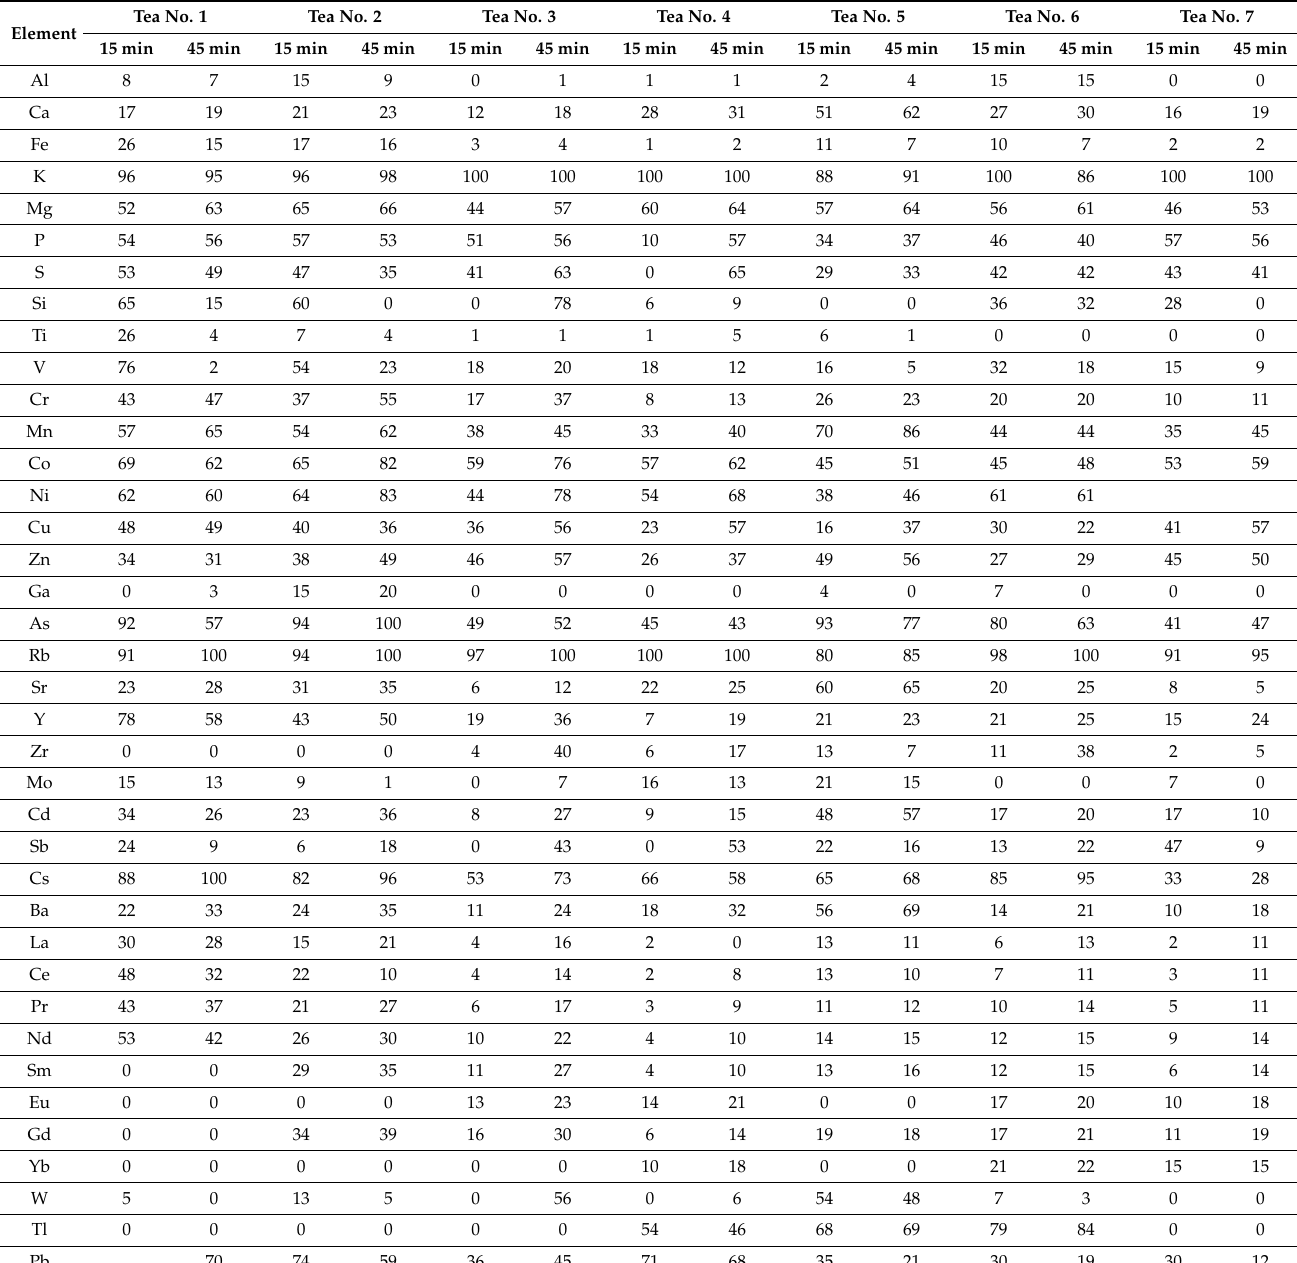
Table 6. Extraction of elements depending on the brewing time